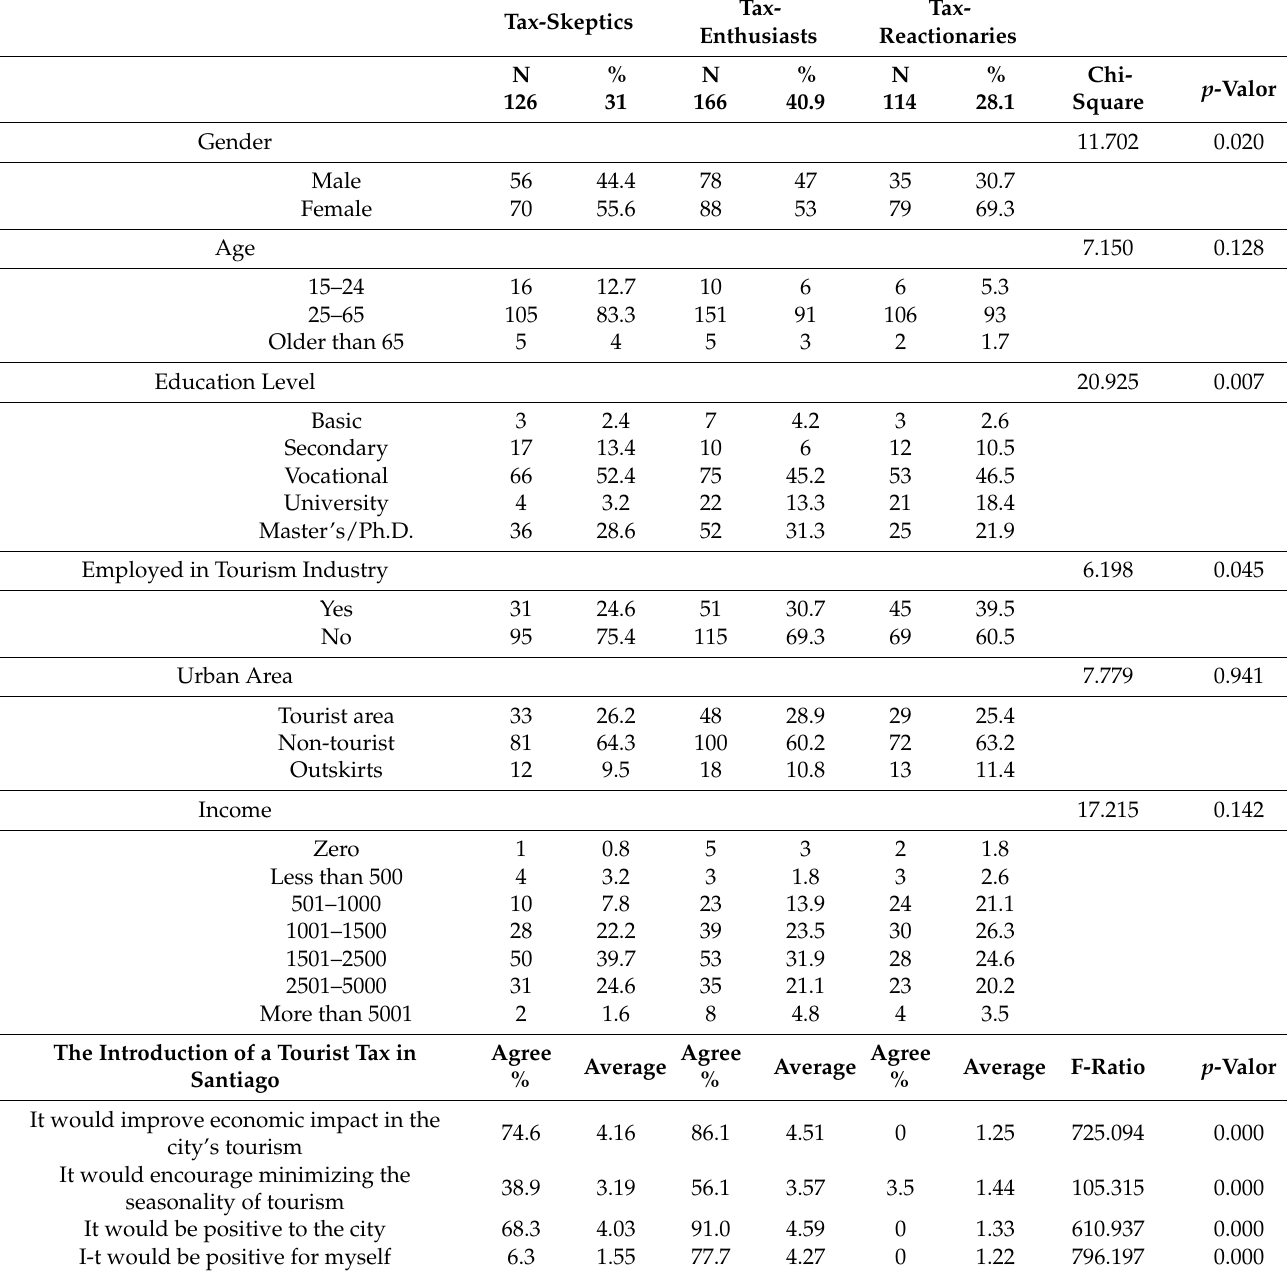
Table 9. Perception of the implementation of the tourist tax by clusters and demographic profile of the